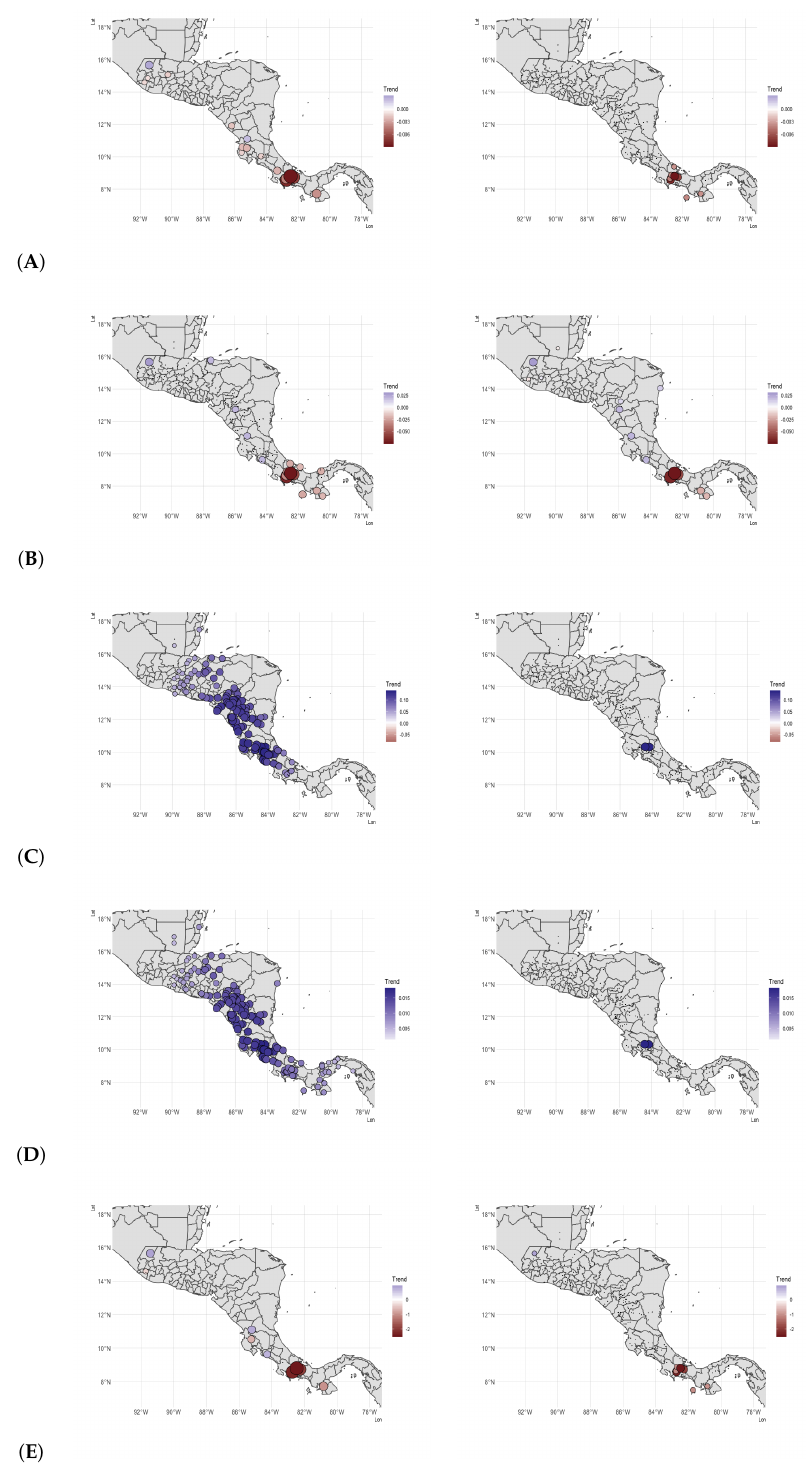
Figure 6. Trend Significance Maps: ( A ) Aridity. ( B ) Runoff. ( C ) PET. ( D ) Temperature. ( E ) Precipitation. Left panel and right panels present the maps assuming spatial independence (Mann–Kendall test) and with a spatial dependence correction, respectively. Dots represent values that are statistically different from zero at a 5% significance level, in both cases.